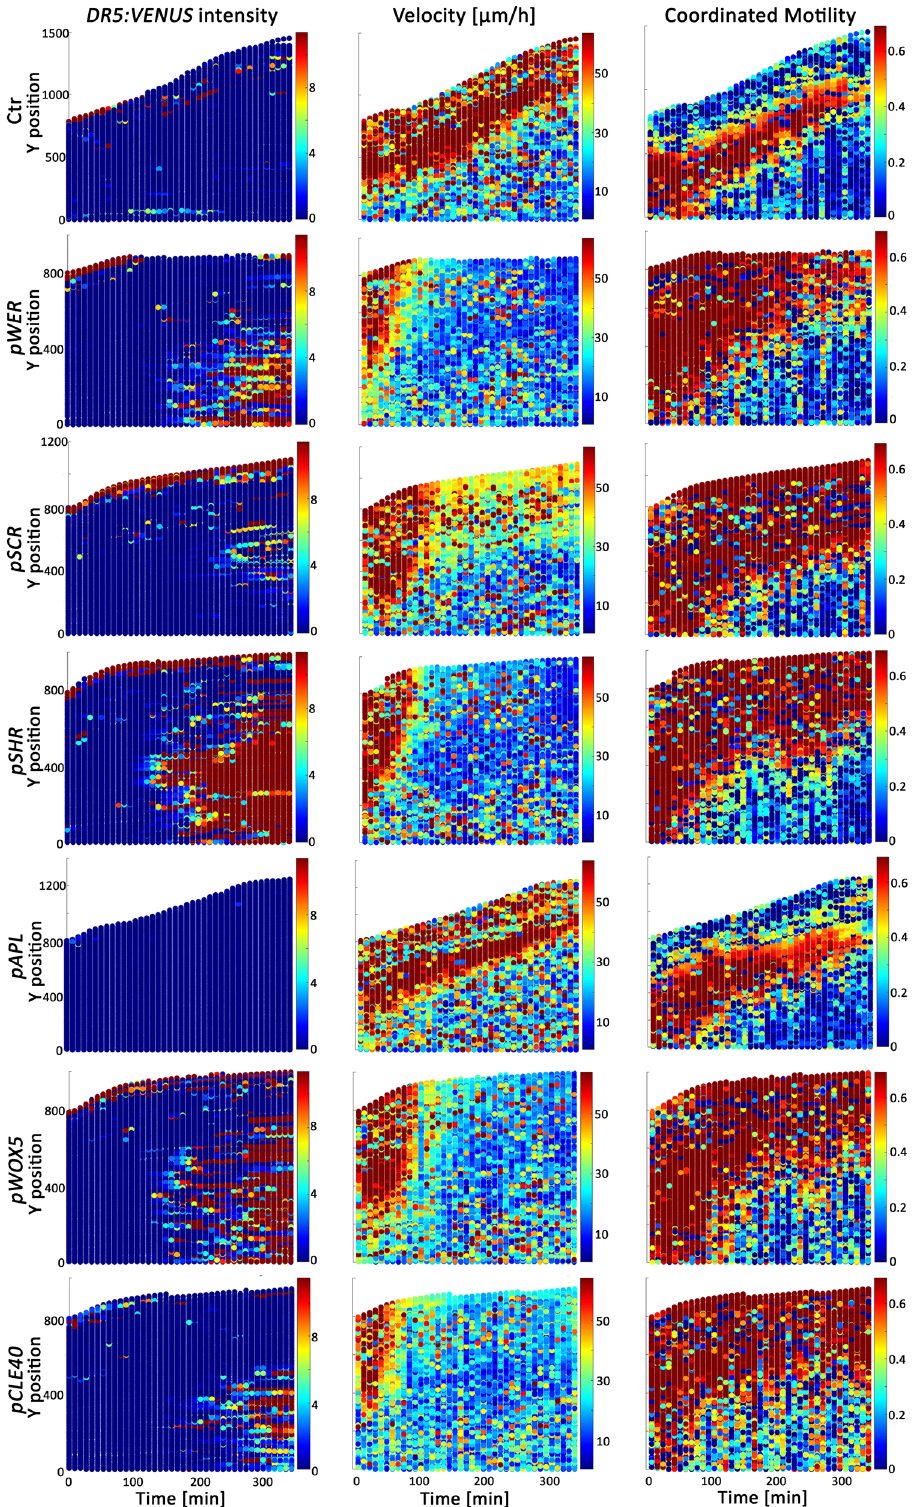
Fig. 4 Cell-type-speci fi c auxin production kinetic response over time and space in the root. Single-cell mean DR5:VENUS intensity (left), velocity (middle), and coordinated motility (right) maps following cell-type-speci fi c auxin induction. Ctr indicates control plants, which are mock-treated pWOX5: XVE:YUC1-TAA1; DR5:VENUS seedlings. Root tip faces upwards. Data are a concatenate of three independent movies of roots of each genotype, each with ~1000 nuclei. T 0 indicates 20 min after 5 μ M estradiol